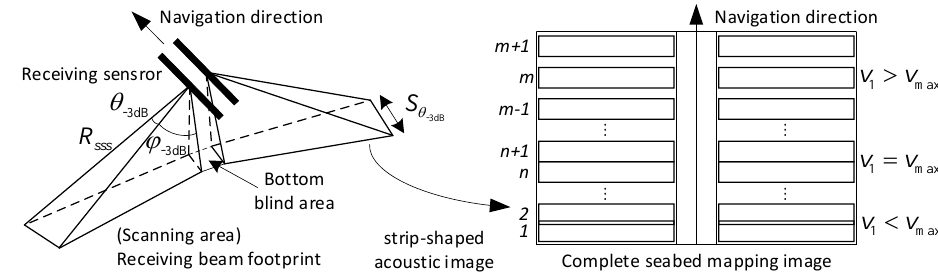
Figure 1. Imaging principle of the single − beam side − scan sonar.